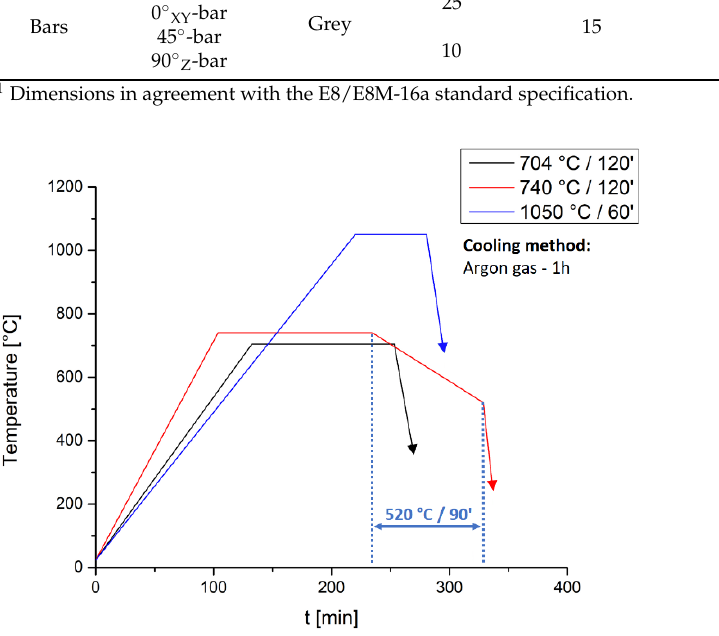
Figure 2. Temperature–time curves related to the heat treatment (704 °C/120 ′ , 740 °C/130 ′ and 1050 °C/60 ′ ) studied in the present work.